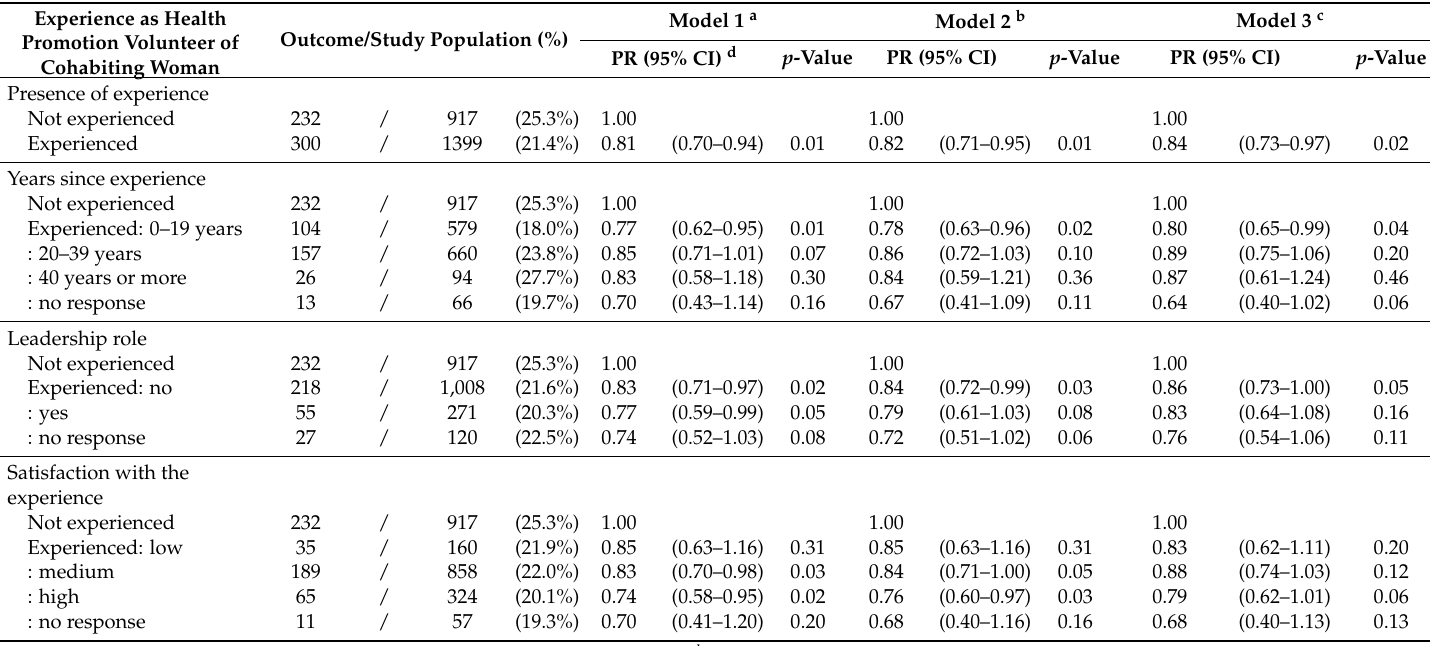
Table 3. Association between cohabiting women’s experience as a health promotion volunteer and depressive symptoms in the study population ( n = 2316). Experience as Health Promotion Volunteer